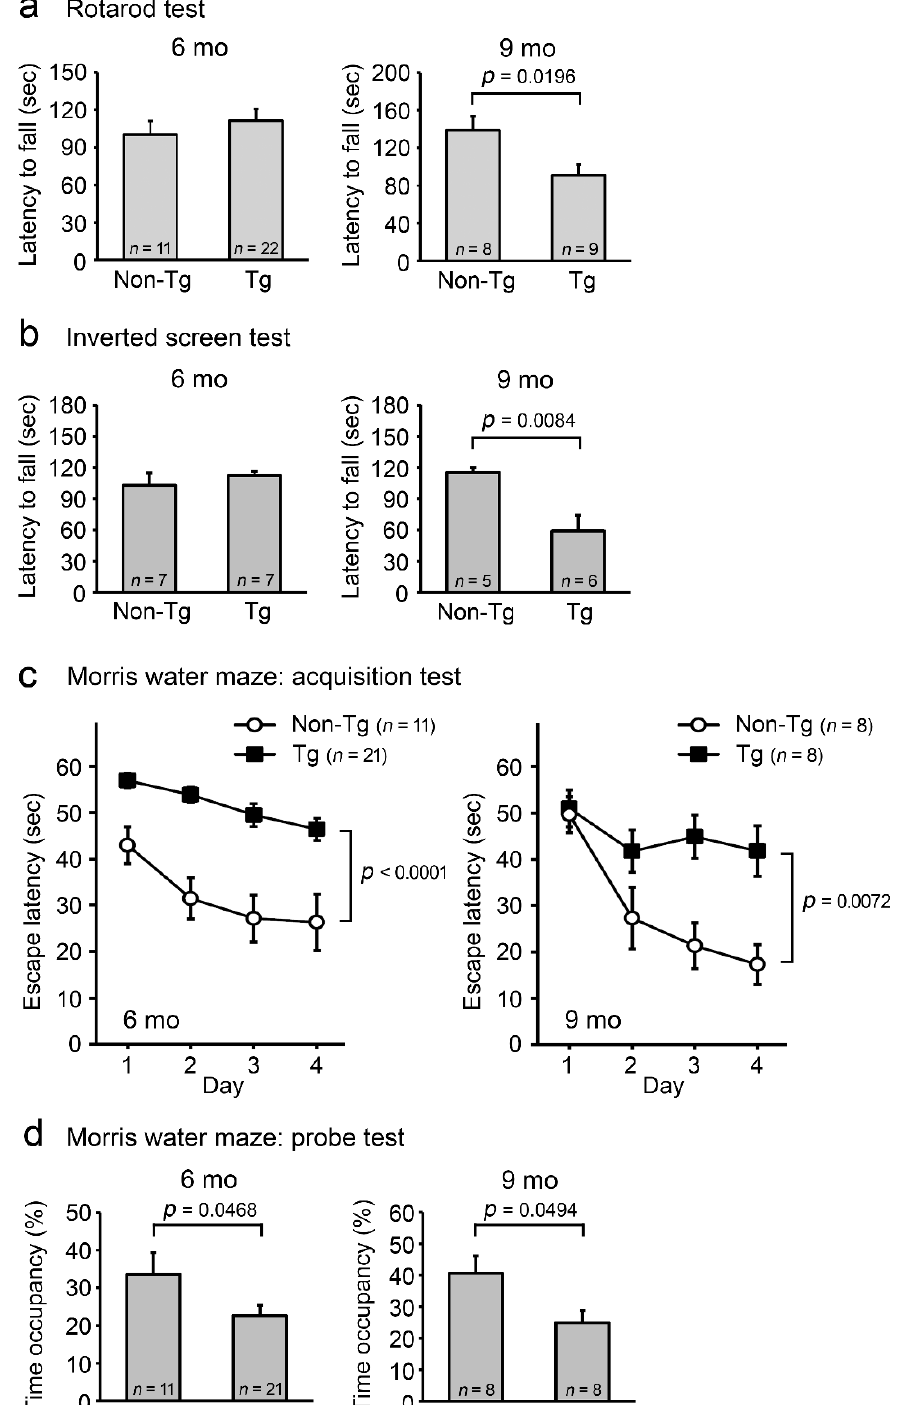
Figure 1. Motor and cognitive functions in A53T-mutant α -synuclein-Tg mice. Male and female littermates were subjected to the rotarod ( a ), inverted screen ( b ), and Morris water maze test ( c , d ) at 6 and 9 months old (mo). The numbers of mice used are shown in each figure. ( a ) In the rotarod test, Tg mice first displayed a motor disturbance at 9 months. ( b ) This trend was confirmed by the inverted screen test using different individuals of age-matched littermates. In the Morris water maze test, memory acquisition ( c ) and retention ( d ) of Tg mice were significantly impaired as early as 6 months.